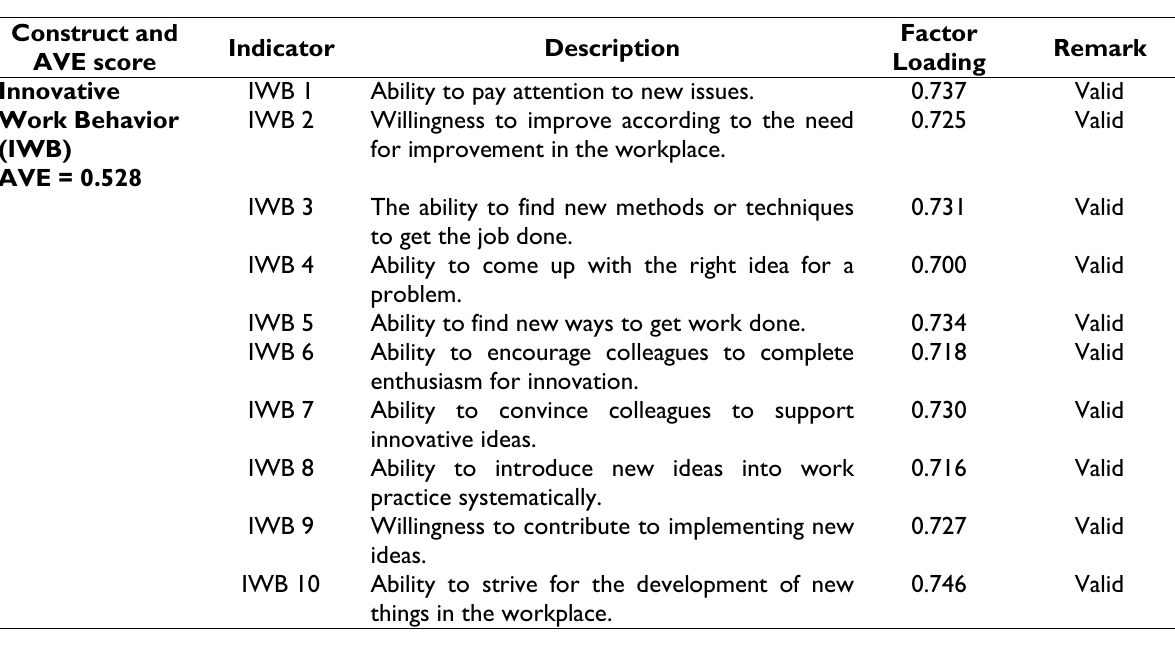
Table 3. Reliability